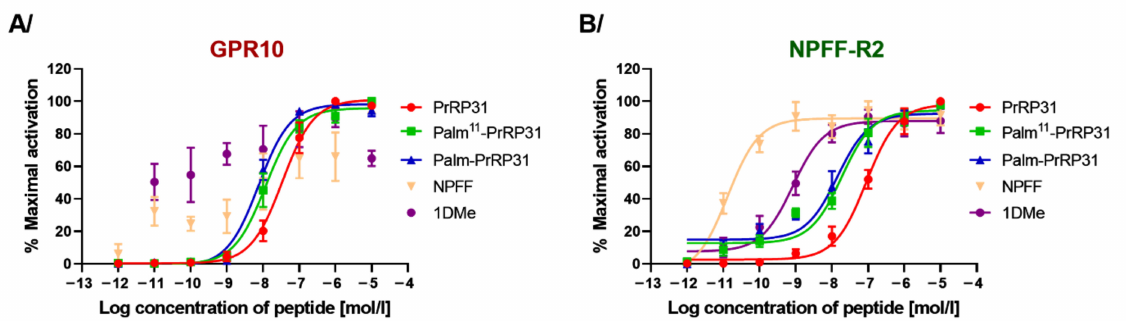
Figure 1. Intracellular Ca 2+ mobilization in CHO-K1 cells expressing ( A ) GPR10 or ( B ) NPFF-R2. Data are presented as mean ± SEM, and the experiments were performed in duplicates and repeated two (GPR10) or three (NPFF-R2) times in